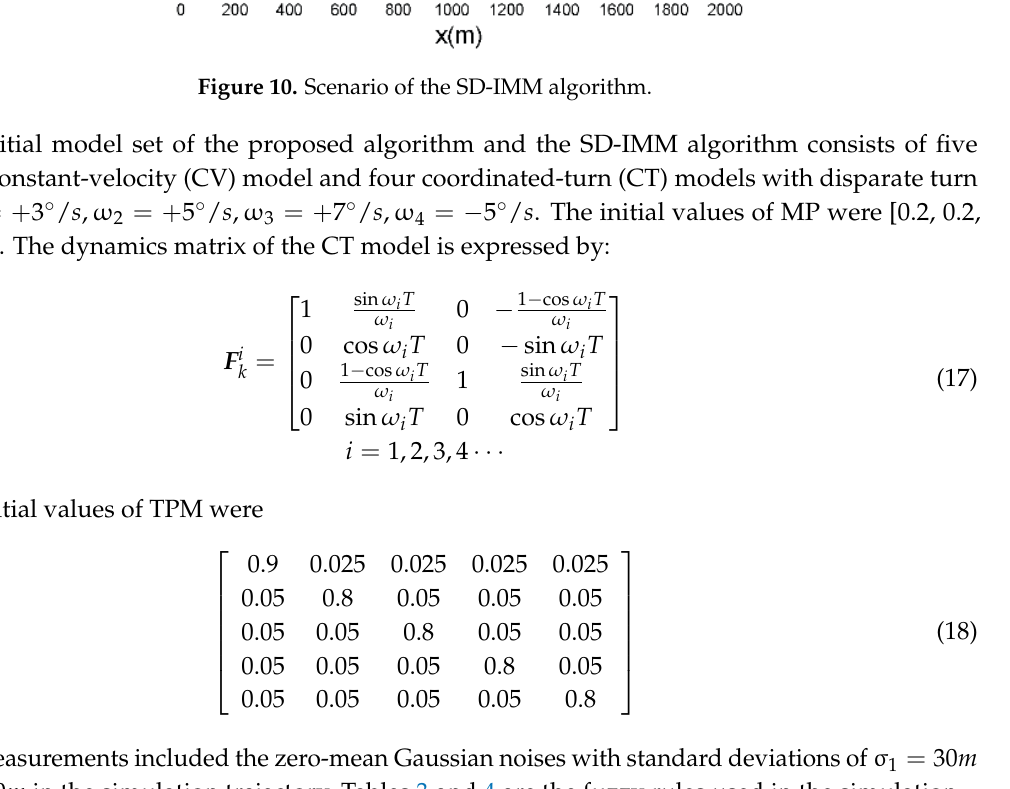
Table 3. Fuzzy rules for S k , B k and J i